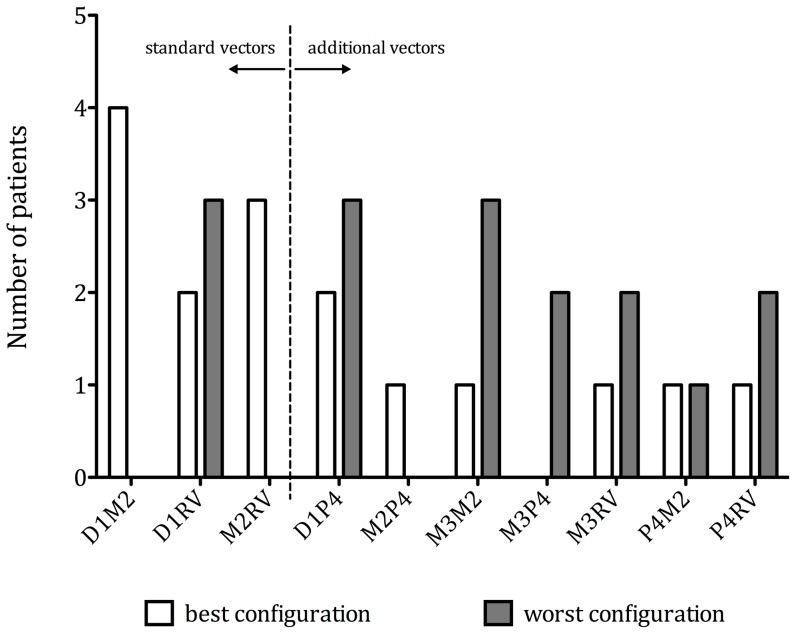
Distribution of optimal (white) and worst (grey) pacing configurations among study patients - Left three columns show configurations programmable with a standard bipolar lead.